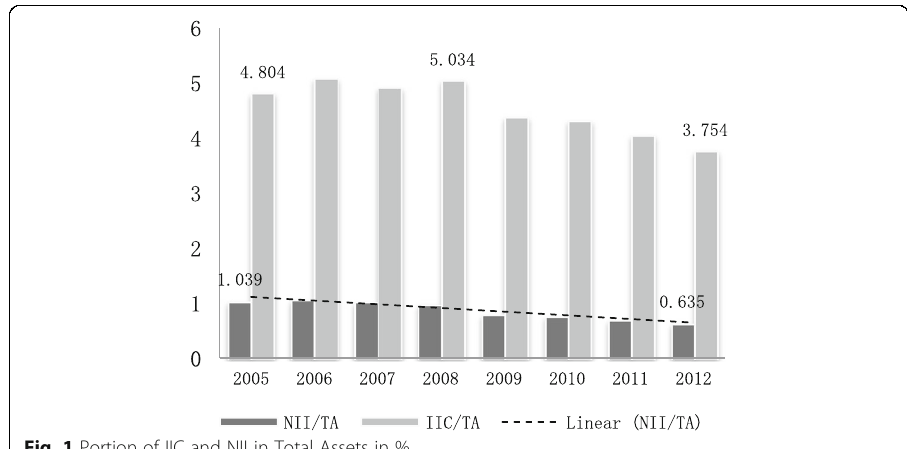
Fig. 1 Portion of IIC and NII in Total Assets in